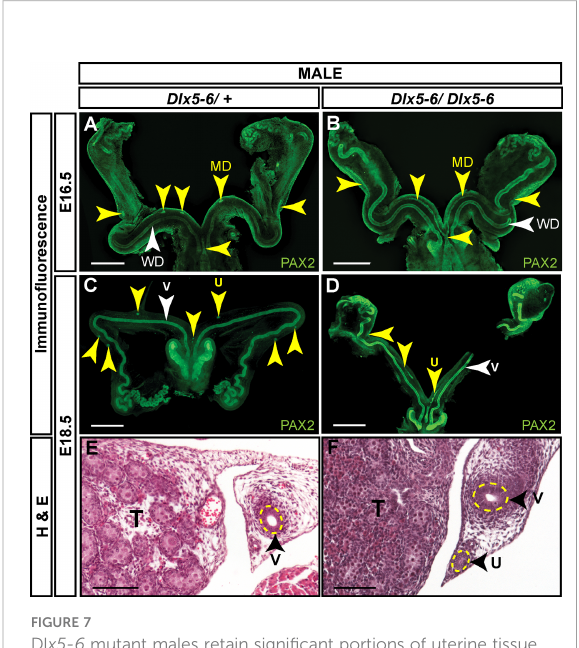
FIGURE 7 Dl x5-6 mutant males retain signi fi cant portions of uterine tissue at E18.5 compared to controls. Wholemount PAX2 immuno fl uorescent staining of E16.5 Dlx5-6/+ (A) and Dlx5-6/ Dlx5-6 (B) male embryos and E18.5 Dlx5-6/+ (C) and Dlx5-6/ Dlx5-6 (D) male embryos. Yellow arrowheads, Müllerian ducts (A, B) and uterus ( C, D ). White arrowheads, Wolf fi an ducts (A, B) and vas deferens ( C, D ). MD, Müllerian duct; WD, Wolf fi an duct; T, testis; v, vas deferens; u, uterus. Scale bars = 500 µm. Hematoxylin (H) and Eosin (E) stained cross sections of the vas deferens (v) adjacent to the testis (T) from E18.5 Dlx5-6/+ (E) and Dlx5-6/Dlx5-6 (F) male embryos. u, uterus. Scale bars =100 µm. E16.5 Dlx5-6/+ (n=4); E16.5 Dlx5-6/Dlx5-6 (n=3); E18.5 Dlx5-6/+ (whole mount n=6, histology n=4); E18.5 Dlx5-6/Dlx5-6 (whole mount n=3, histology n=3).